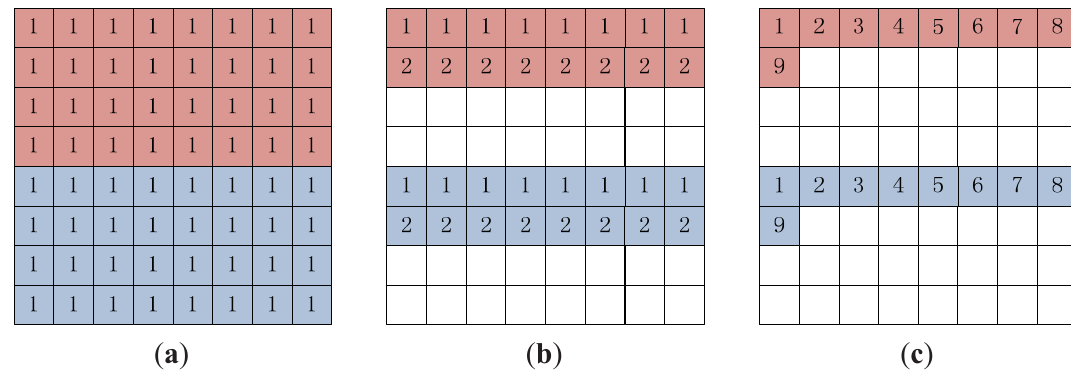
Figure 2. Schematic illustration of the three approaches to the SENSE reconstruction. The acceleration rate is 2. The upper 4 × 8 (pink) and the lower 4 × 8 (blue) matrices in the above represent the voxels in the aliased images. The full image is an 8 × 8 matrix. ( a ) Non-iterative method: we unfold the aliased images to obtain the full image in one iteration; ( b ) Line-by-line iteration method: we obtain the estimated voxels of the 1 st and the 5 th rows in the first iteration, and the 2 nd and the 6 th rows in the 2 nd iteration, and so on; ( c ) Pixel-by-pixel method: we obtain the estimated voxels in pairs. The digits i in the image denotes the voxel is estimated at the i- th